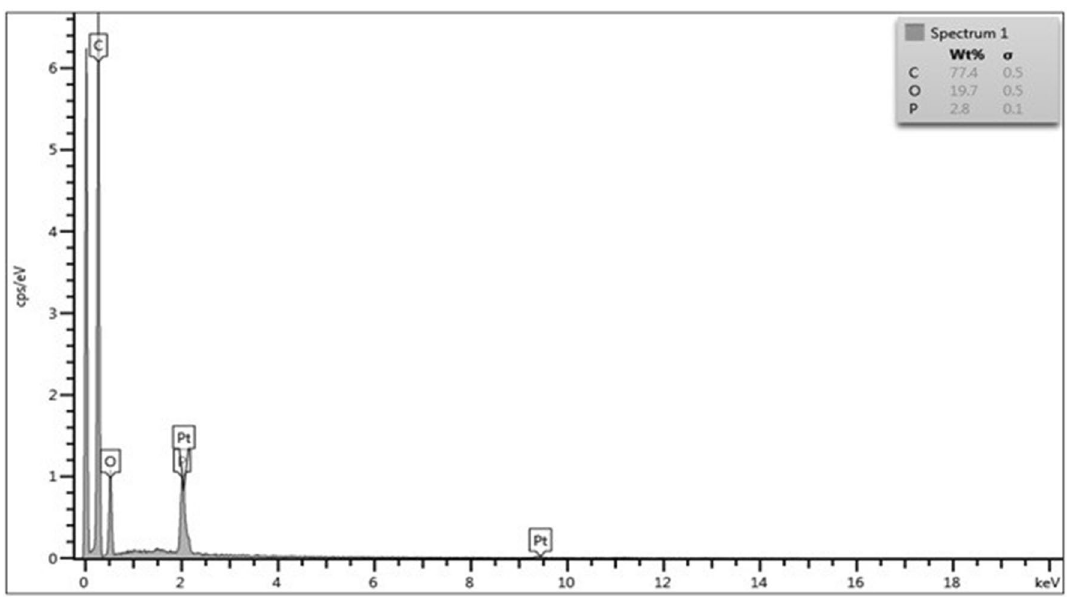
Fig. 2 Different elements observed during scanning electron microscopic analysis of activated carbon made from coconut shell Fig. 3 Scanning electron micro- scopic analysis of activated carbon made from banana